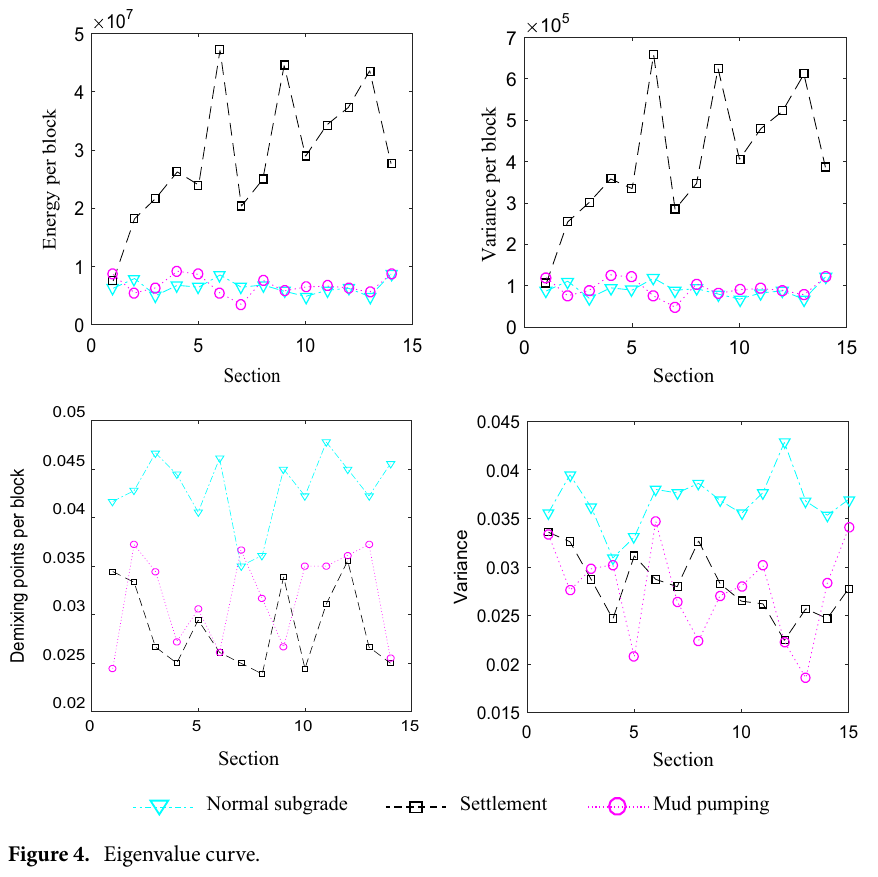
Figure 4. Eigenvalue